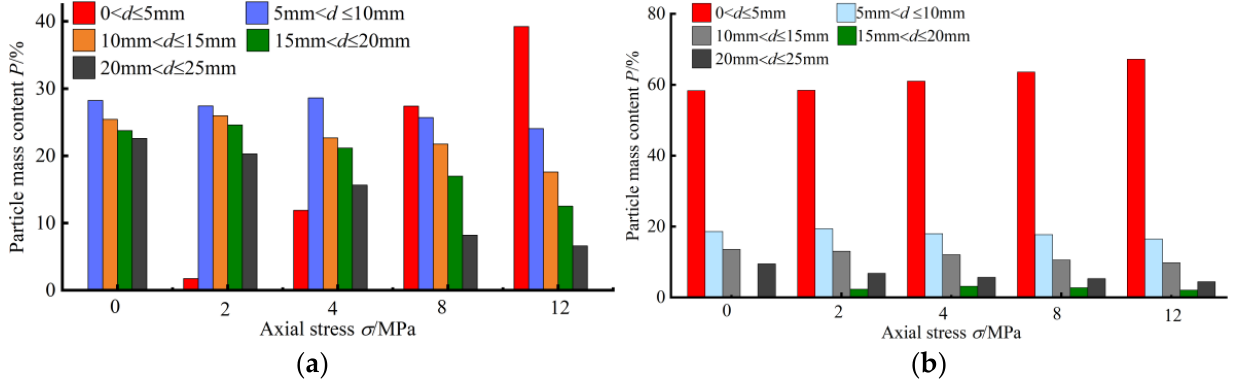
Figure 8. Particle size mass percentage – axial stress relationship. ( a ) Intermittent 0 – 5 mm particle size grading structure; ( b ) intermittent 15 – 20 mm particle size grading structure.